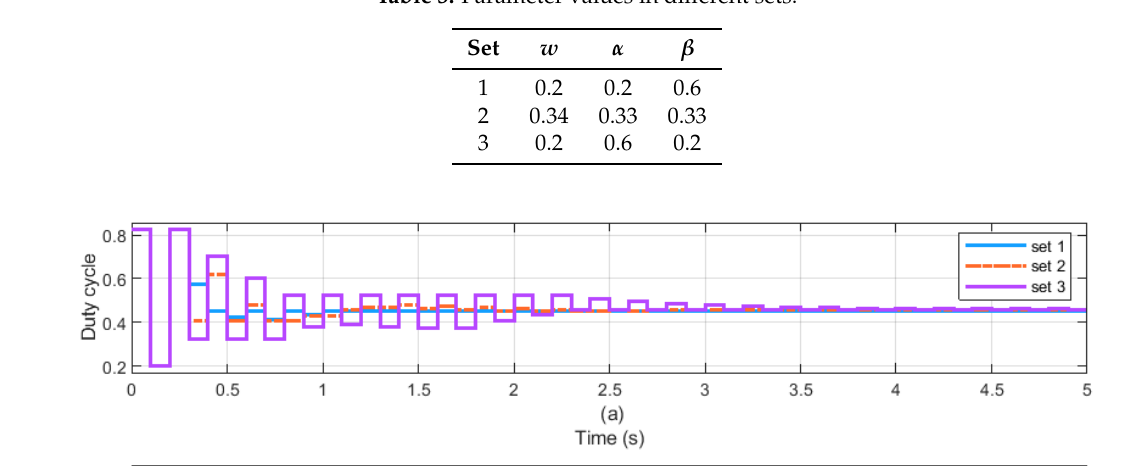
Table 3. Parameter values in different sets.